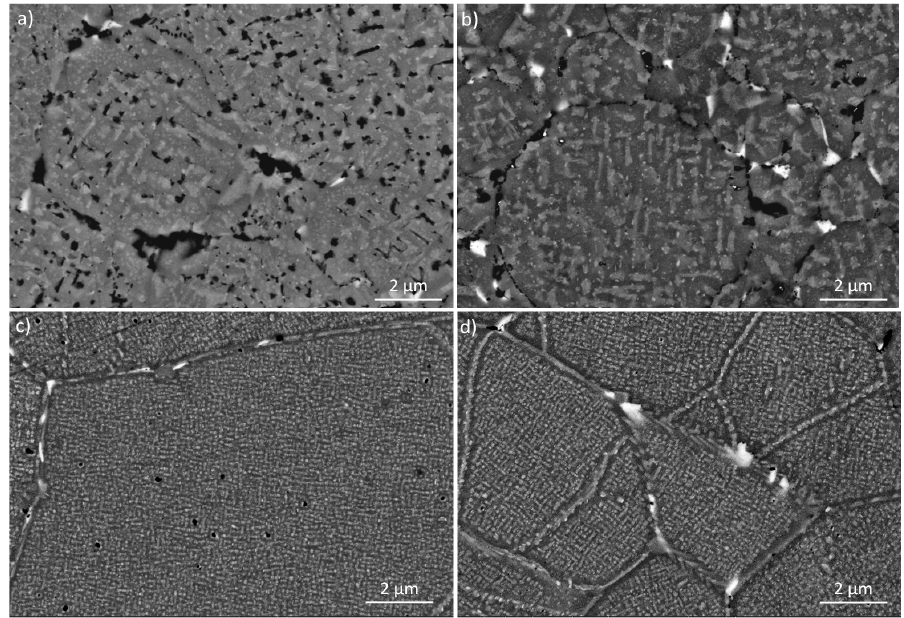
Figure 5. Microstructure of samples sintered by SPS: ( a ) and ( b ) at 1000 °C for 1 and 5 min as holding time, respectively; ( c ) and ( d ) 1100 °C for 1 and 5 min as holding time, respectively.